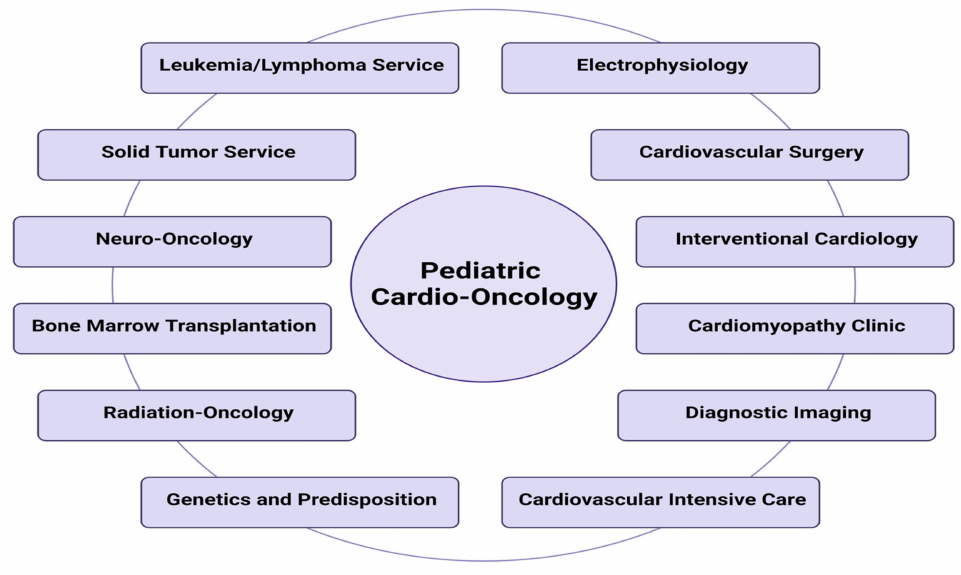
Figure 1. Stakeholders caring for pediatric cardio-oncology patients. Created with